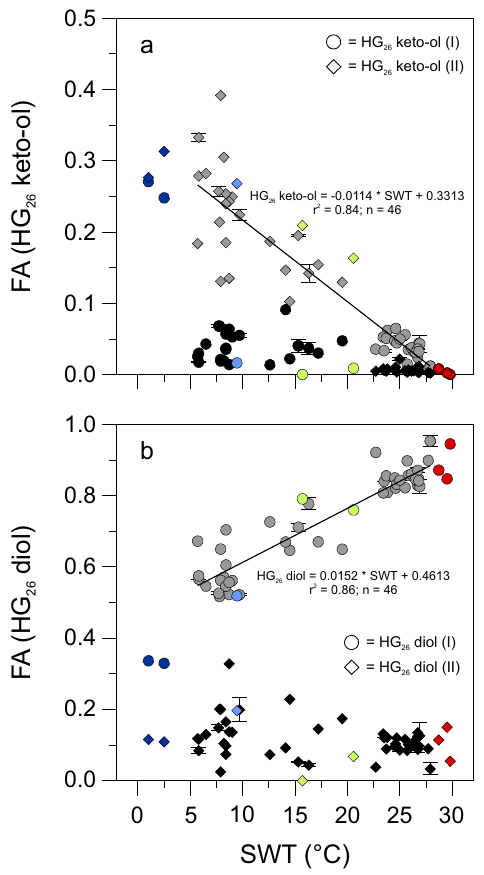
Fig. 4 Fractional abundances of heterocyte glycolipids in East African lakes as well as other polar to tropical lakes and ponds. Regression analysis demonstrates that fractional abundances (FA) of ( a ) HG 26 keto-ols are negatively and that of ( b ) HG 26 diols are positively correlated with surface water temperature (SWT). The most dominant structural isomers of both component classes in the East African (indicated in gray) and polar to tropical lake surface sediments showed the strongest correlation with SWT and were used for the calculation of the HDI 26 . Fractional abundances of HG 26 keto-ols and HG 26 diols found in surface sediments of polar to tropical lakes and ponds are shown for comparison and express similar compositional changes across the investigated temperature interval as observed for the East African lake sample set. Red circles and diamonds = tropical Indonesian lakes (Lake Klakah, Lake Lading, and Lake Towuti); Green circles and diamonds = temperate European lakes (Lake Constance and Lake Schreventeich 16 ); Light blue circle and diamond = subpolar Laguna Potrok Aike; Dark blue circles and diamonds = Antarctic meltwater ponds. Error bars indicate the SD of the fractional abundances based on replicate sample